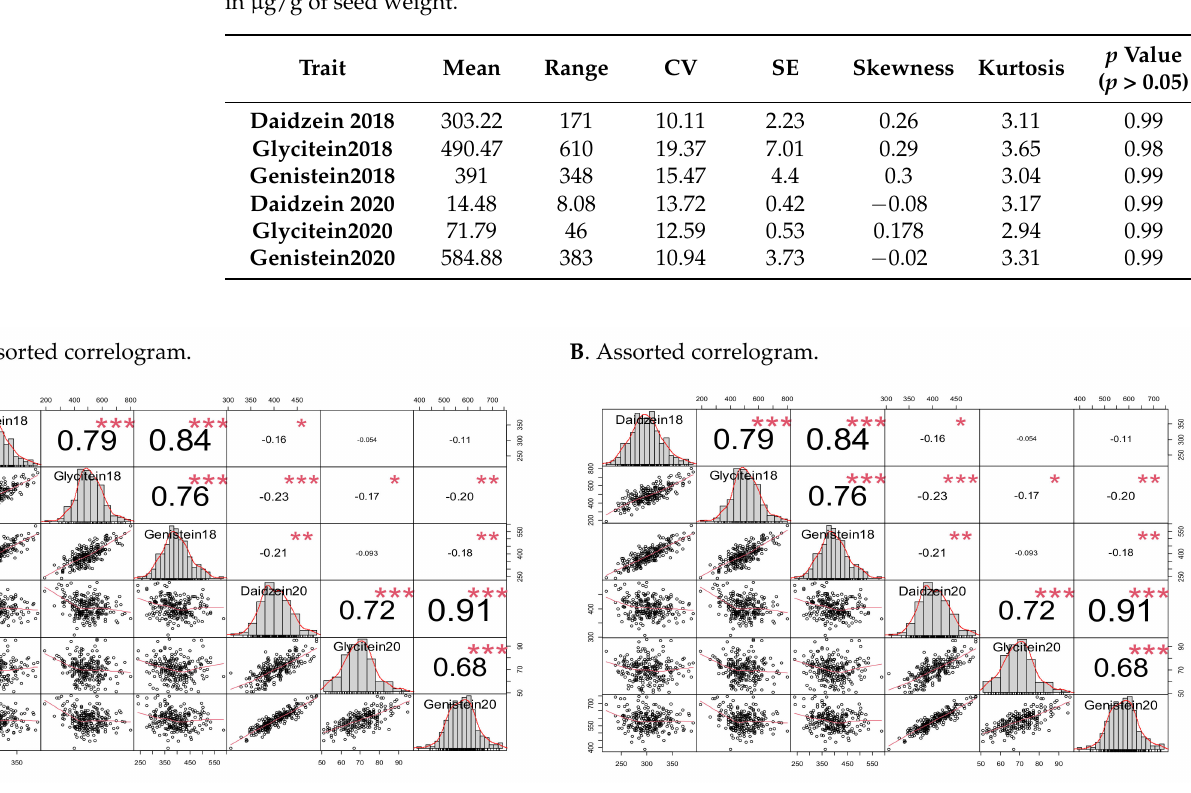
Figure 2. Correlations between daidzein, glycitein, and genistein in the two locations and years: Spring Lake, NC (2018) and Carbondale, IL (2020). ( A ). Unassorted correlogram, ( B ). Assorted correlogram. Significance level: * p < 0.05, ** p < 0.01, *** p <